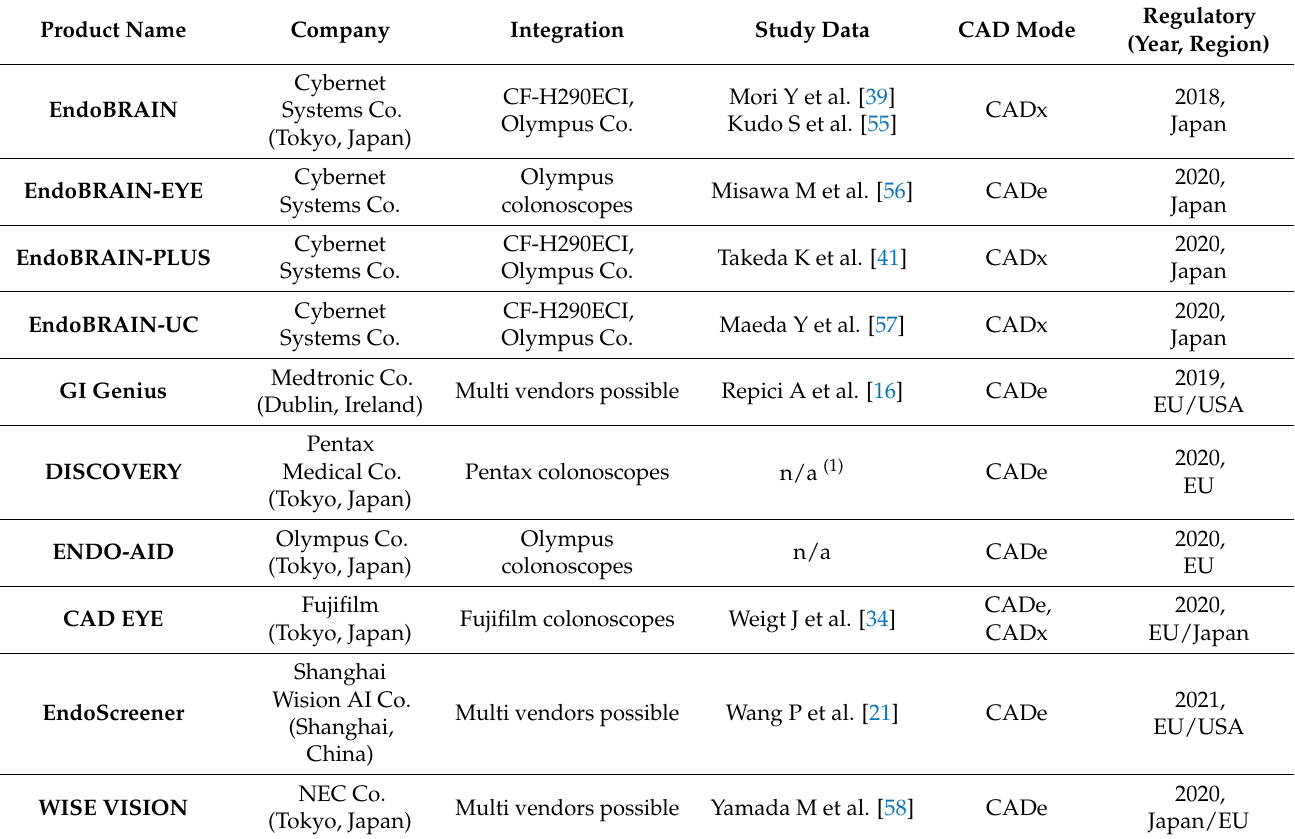
Table 2. Overview of commercial CAD